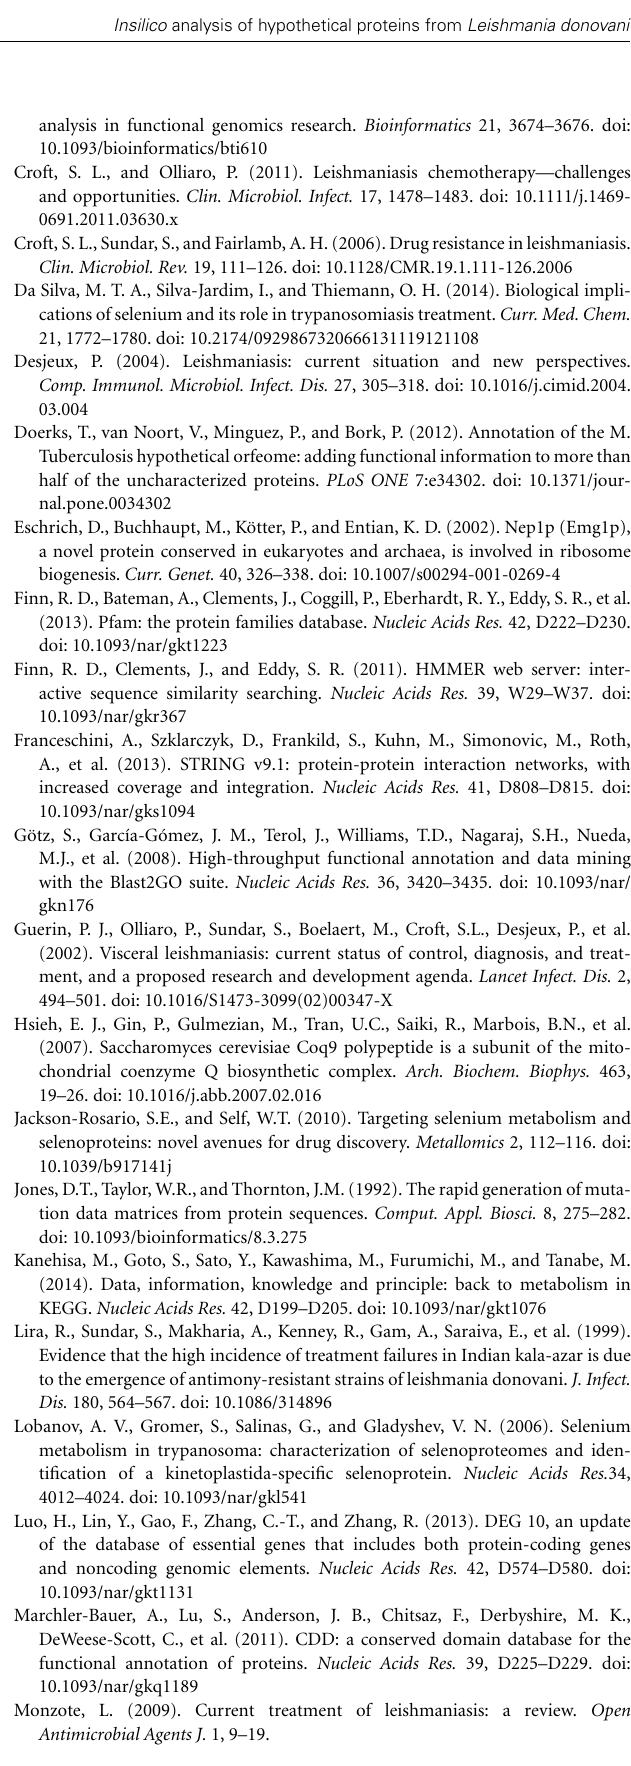
Supplementary Figure 6 | MetaCyc representation of Seleno-cysteine Metabolism. E9B9Y6 (part of 105 sequence dataset) is associated to Seleno-cysteine synthase (EC 2.9.1.2) in the pathway. Supplementary Figure 7 | Unedited Phylogenetic tree with bootstrap values for 12 query sequences associated to 32 DEG hits. Supplementary Table 1 | Information containing GO terms, Interproscan domain association, homologs picked during the BLAST step in the BLAST2GO analysis for the 105 sequences. Supplementary Table 2 | Sequence wise association of pathway information obtained from KASS for 27